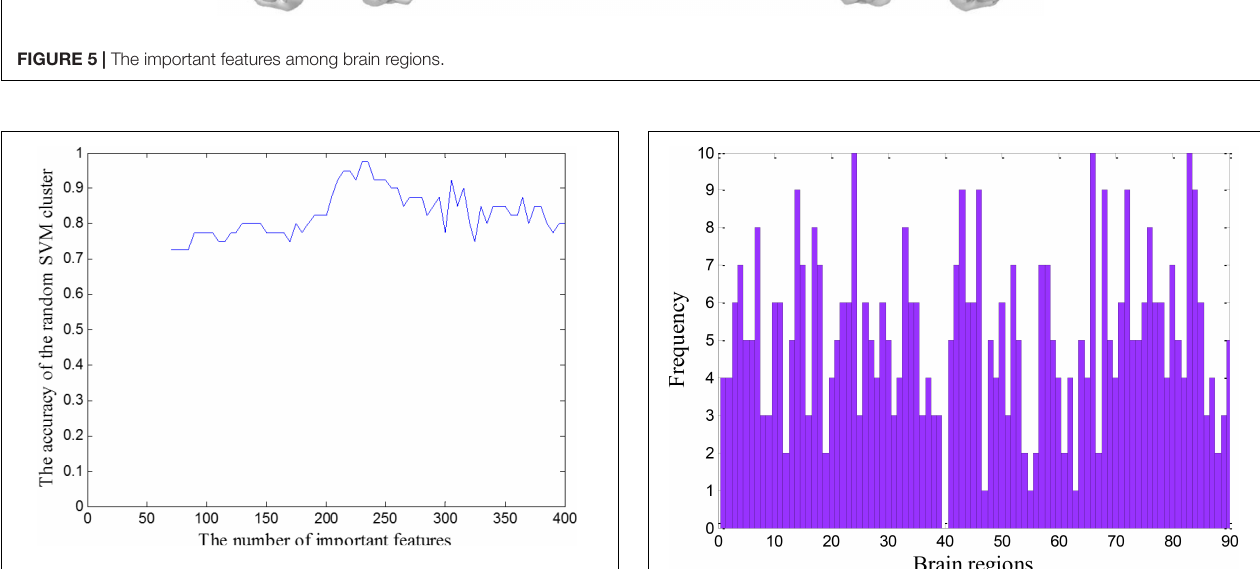
higher frequencies were used as the significant brain regions.